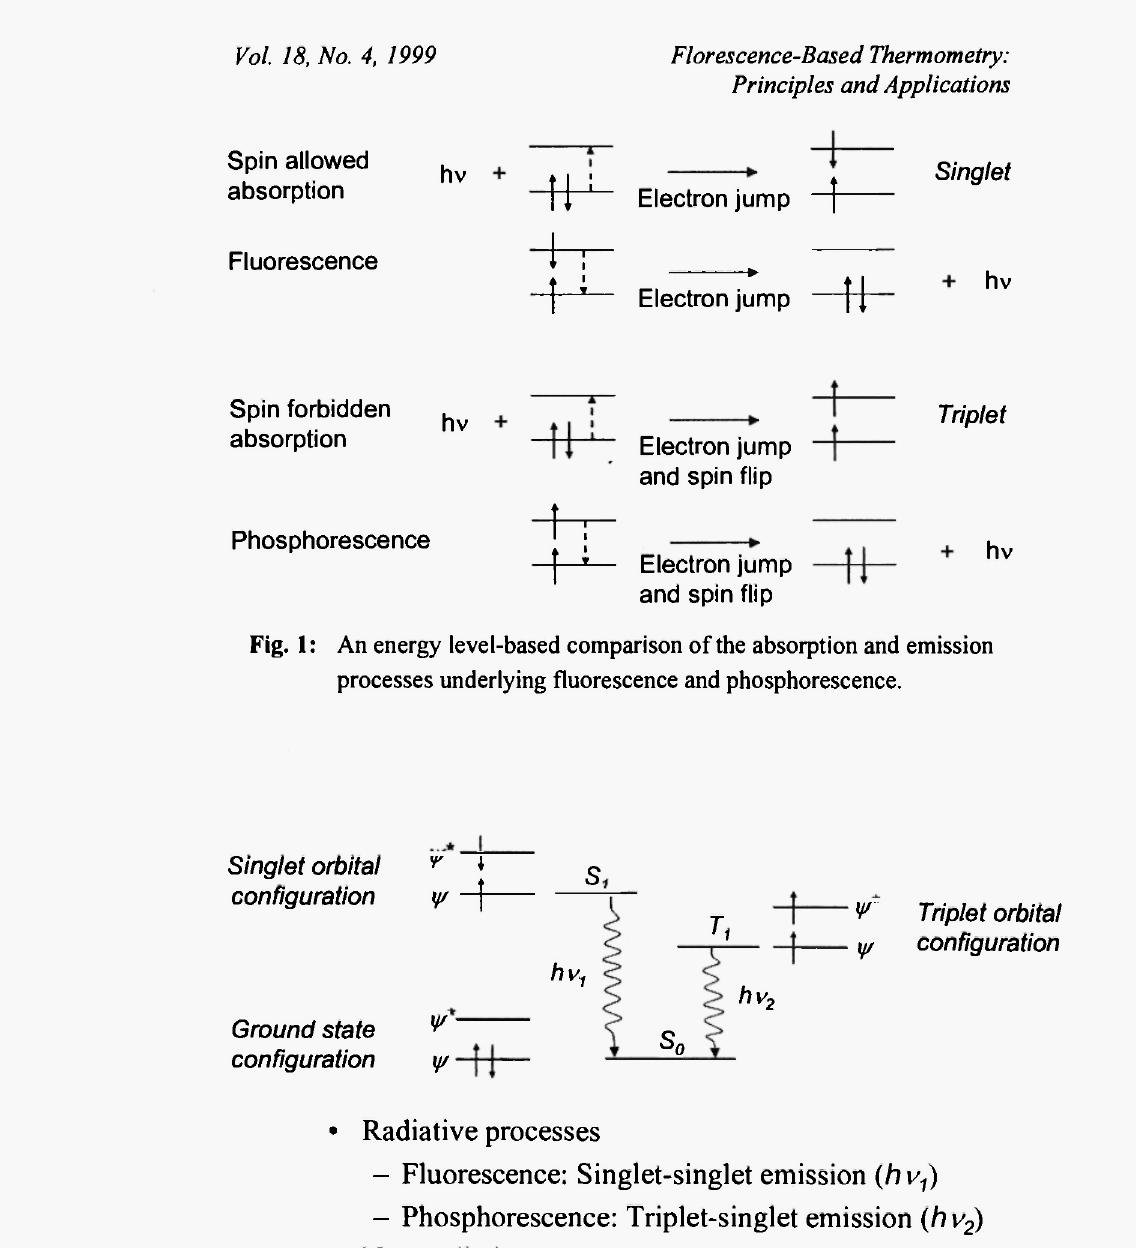
Fig. 2: Comparison of the photophysical processes associated with electron transitions between the ground and excited electronic